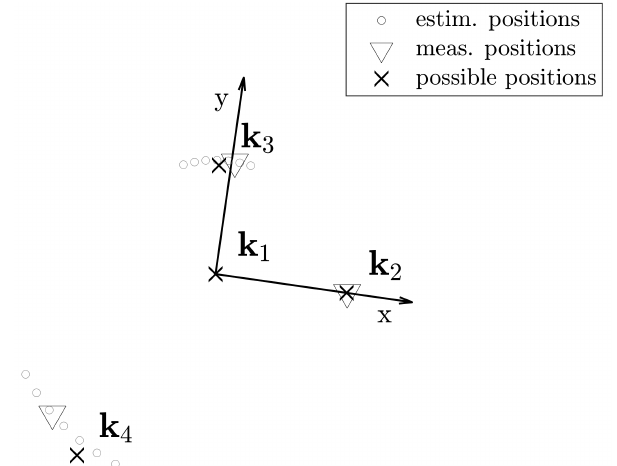
Figure 9. Possible space and initialization after direction adjudgment . Notice that the subspace of possible solutions is reduced from circles to arcs and then to points k 3 and k 4 , which are used for